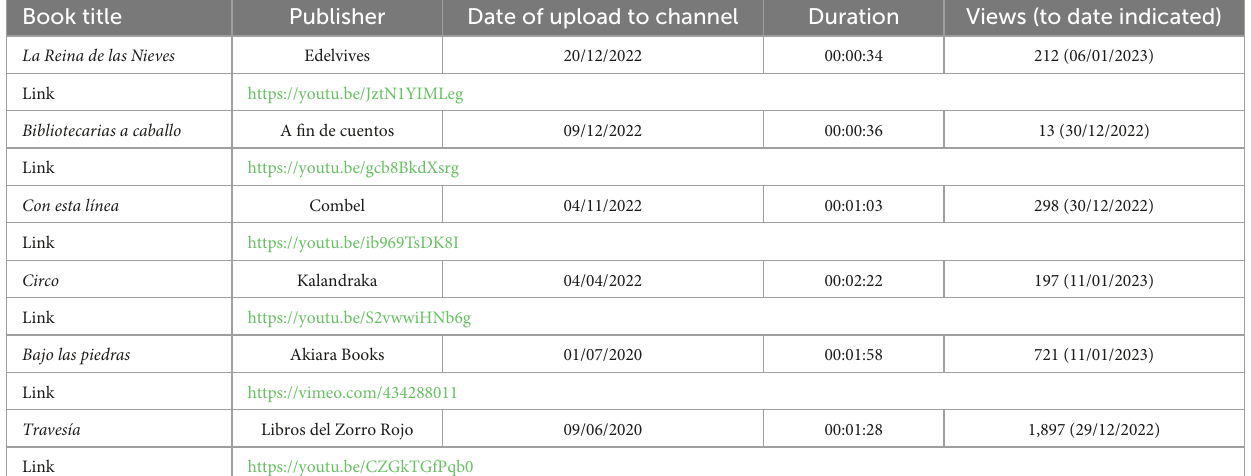
TABLE 7 Examples of animated and cinematic-style book